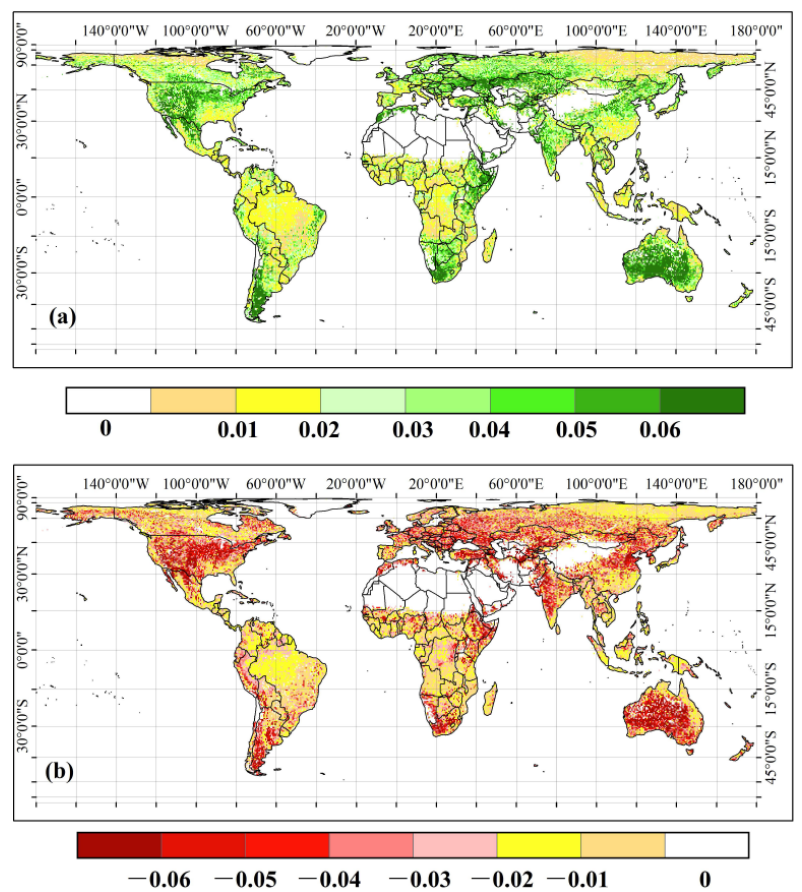
Figure 2. Spatial pattern of the ( a ) positive and ( b ) negative CUE extremes.